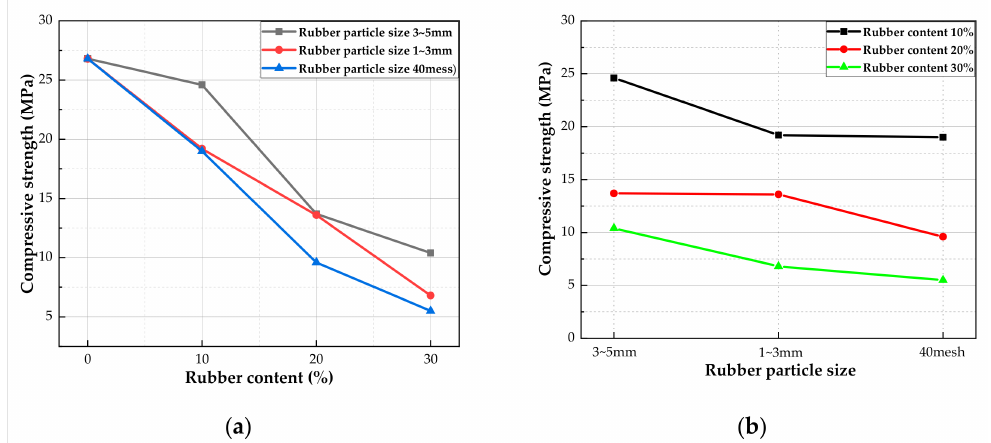
Figure 9. E ff ects of rubber content and rubber particle size on compressive strength. ( a ) E ff ect of rubber content on compressive strength and ( b ) e ff ect of rubber particle size on compressive